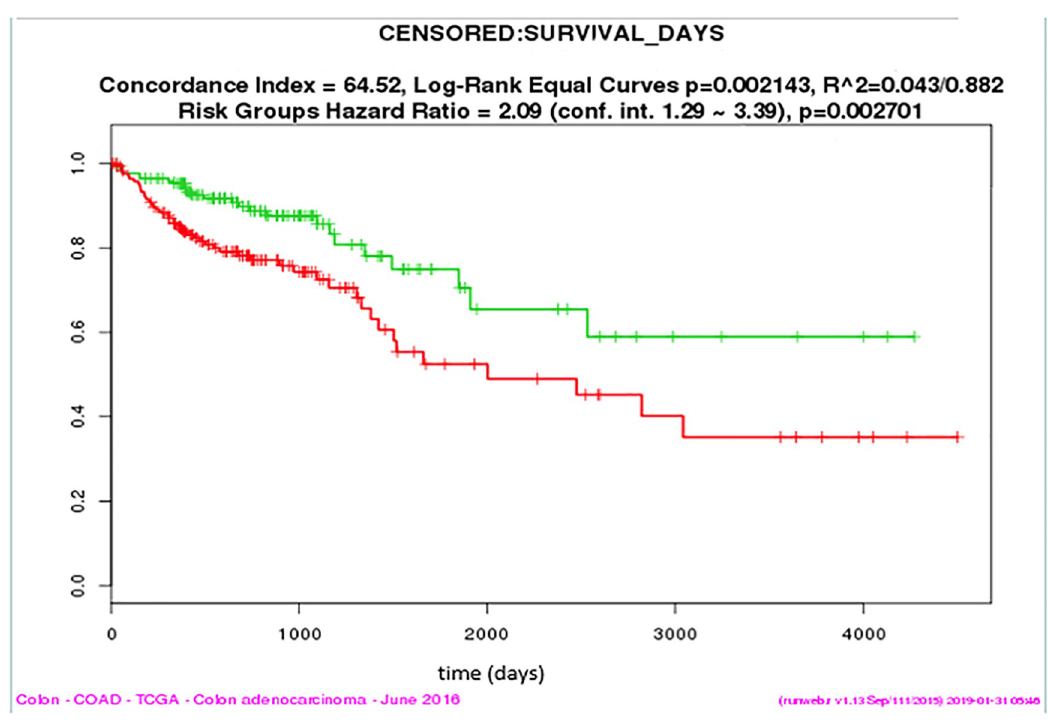
Fig 7. Kaplan–Meier Plotter of relapse-free survival evaluating genes expressed in HCARS module from CMS4 using TCGA COAD clinical data. Red curve represented high expression level and indicated the poor prognosis, while green curve represented low expression level of the prognosis